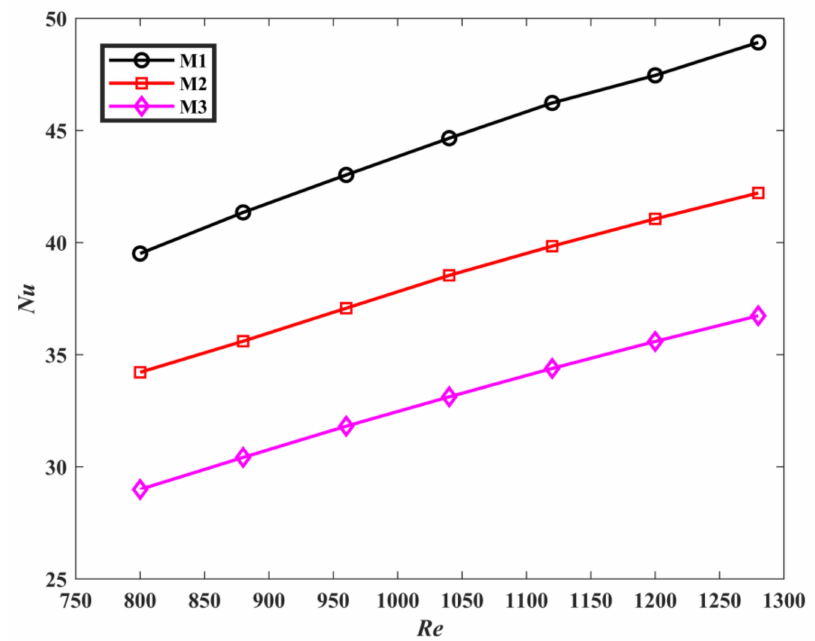
Figure 11. The Nu of the three mini-channels varies with Re .